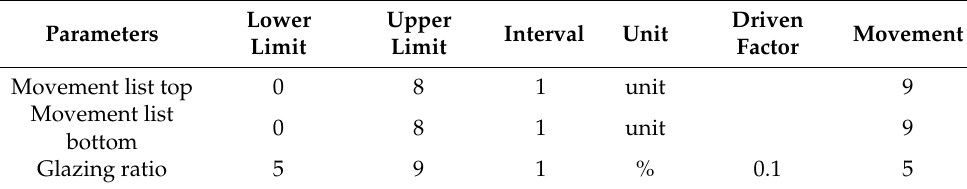
Table 3. Dynamic parameters for daylight